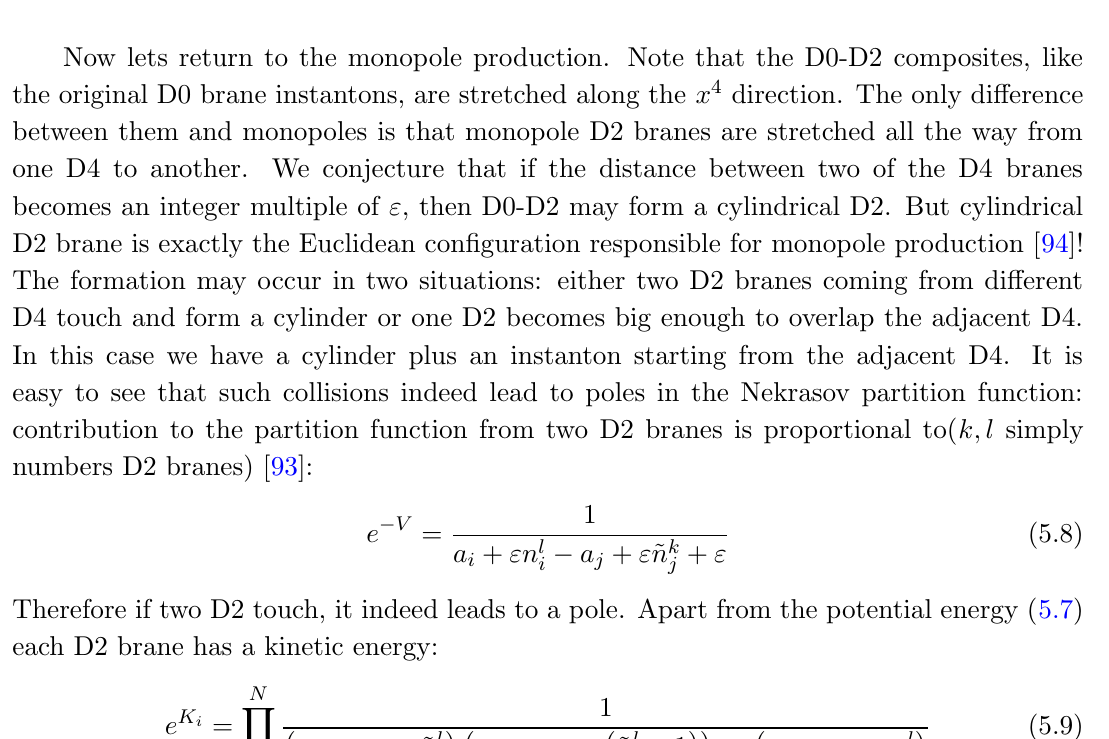
(cid:16) (cid:17) ~ n j + 1 = 2 on the other. The only requirement is that D2 should not coincide: i